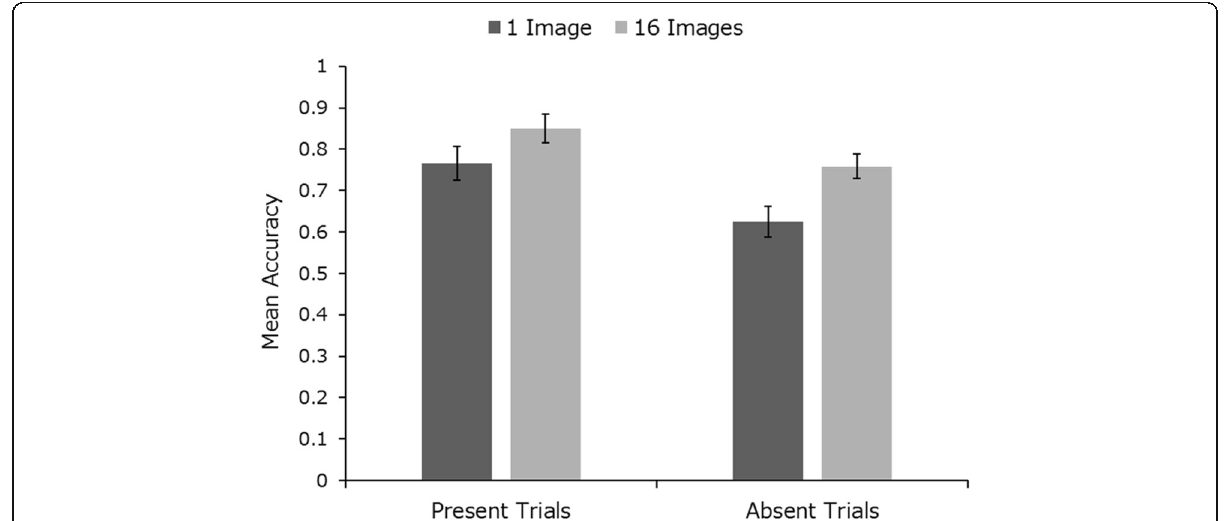
Fig. 4 Mean identification accuracy across trial type for trials with 1 image and with 16 images in study 2. Error bars represent within-subjects standard error (Cousineau,